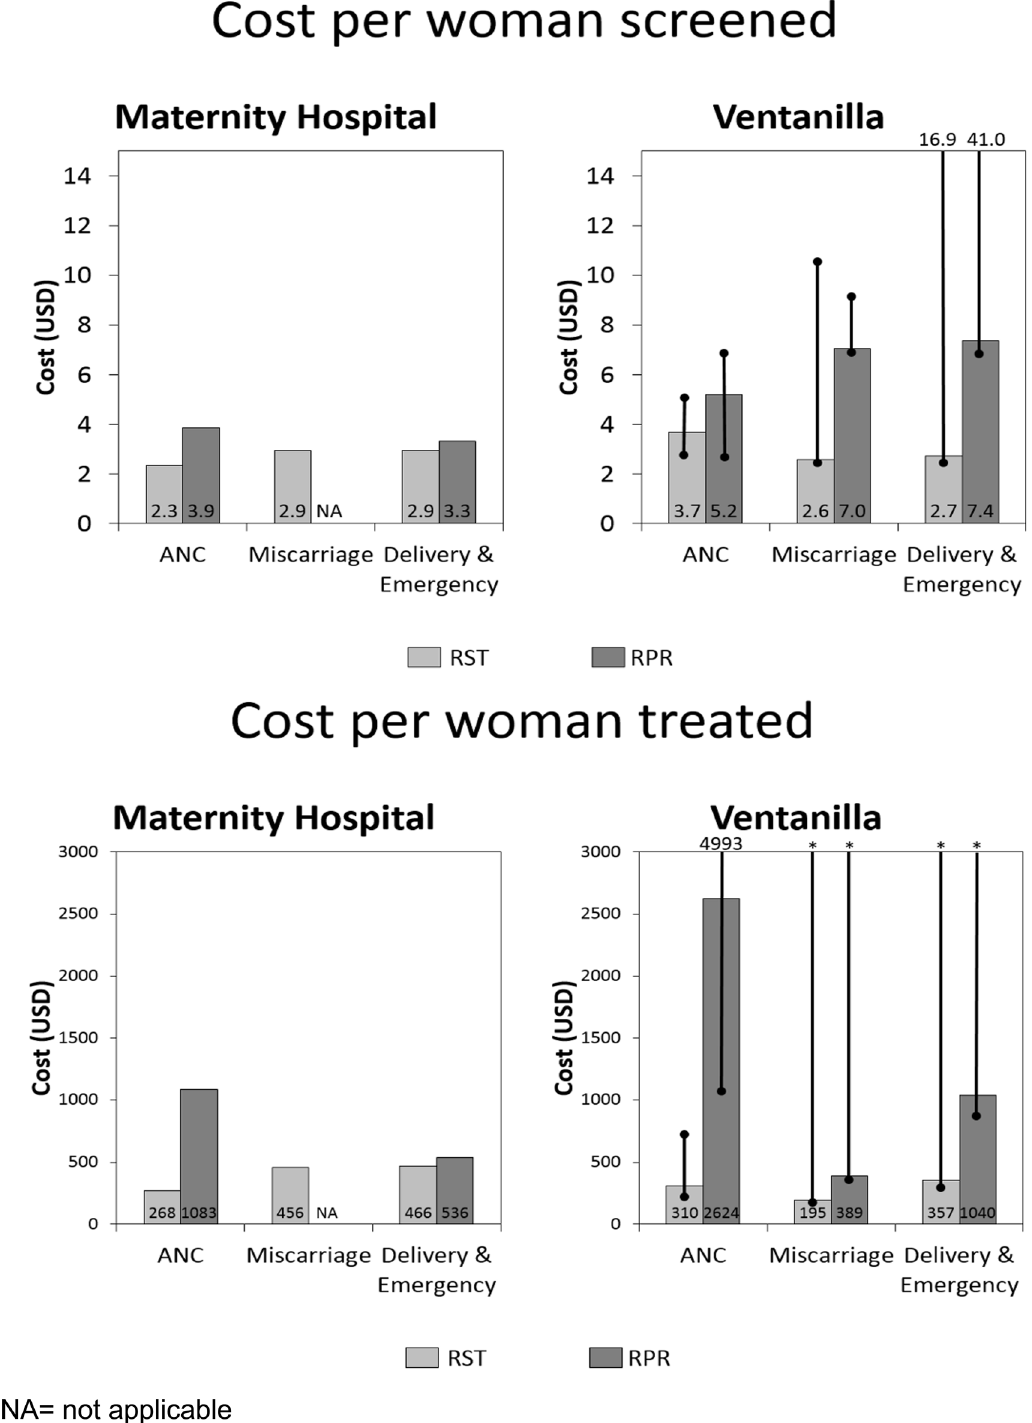
Fig 2. Costs per woman screened and treated, by service comparing RST vs RPR at INMP and Ventanilla Network.